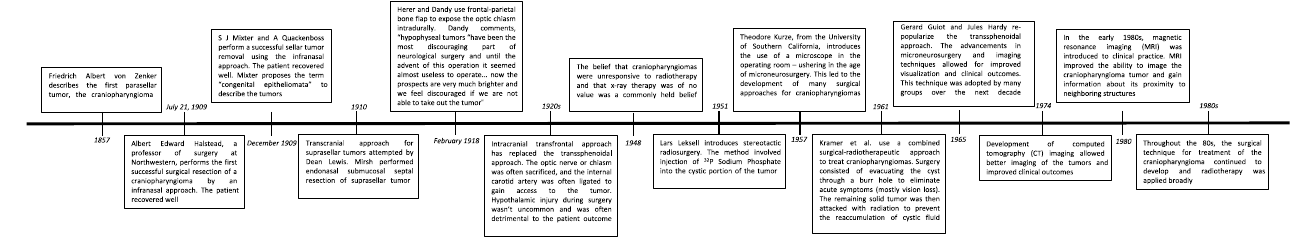
Figure 6. Timeline that includes the preceding events that lead the development of the surgical and radiation treatments of CPs